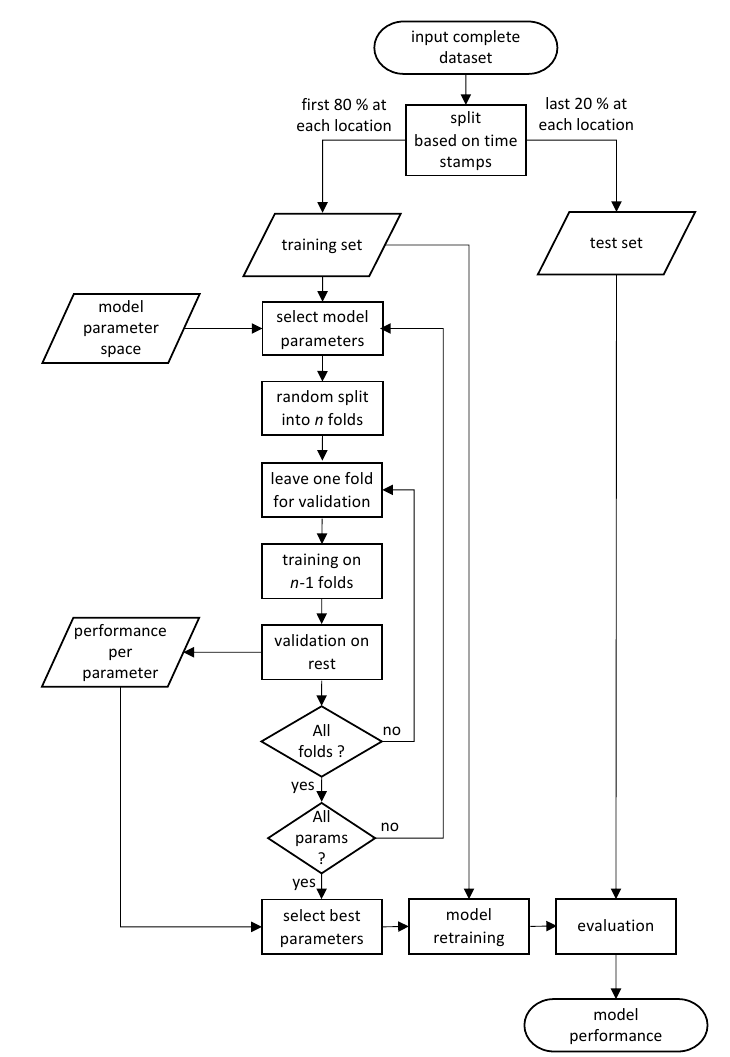
Figure 7. Flowchart of the model training and testing procedure. There are two phases of the training. At first, we look for the best model parameters on the training data (with no knowledge of the test data) by splitting the training data into n folds, then training on n